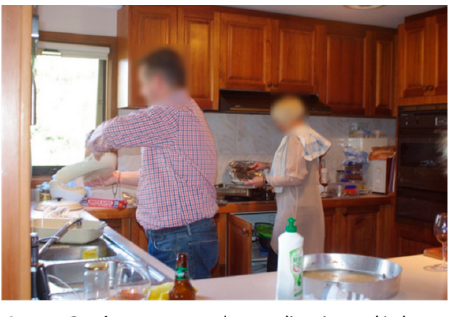
Figure 19. The integrated result of the enhanced image captioning.